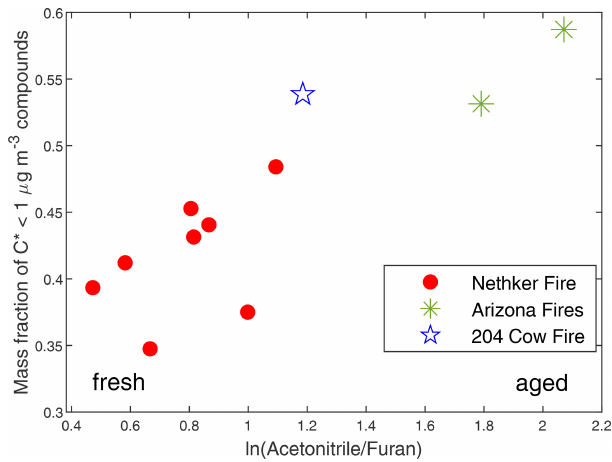
Figure 8. Mass fraction of summed concentrations of observed particle-phase compounds with C ∗ < 1µgm − 3 in total quanti- fied OA as a function of photochemical age represented by ln(Acetonitrile / Furan).